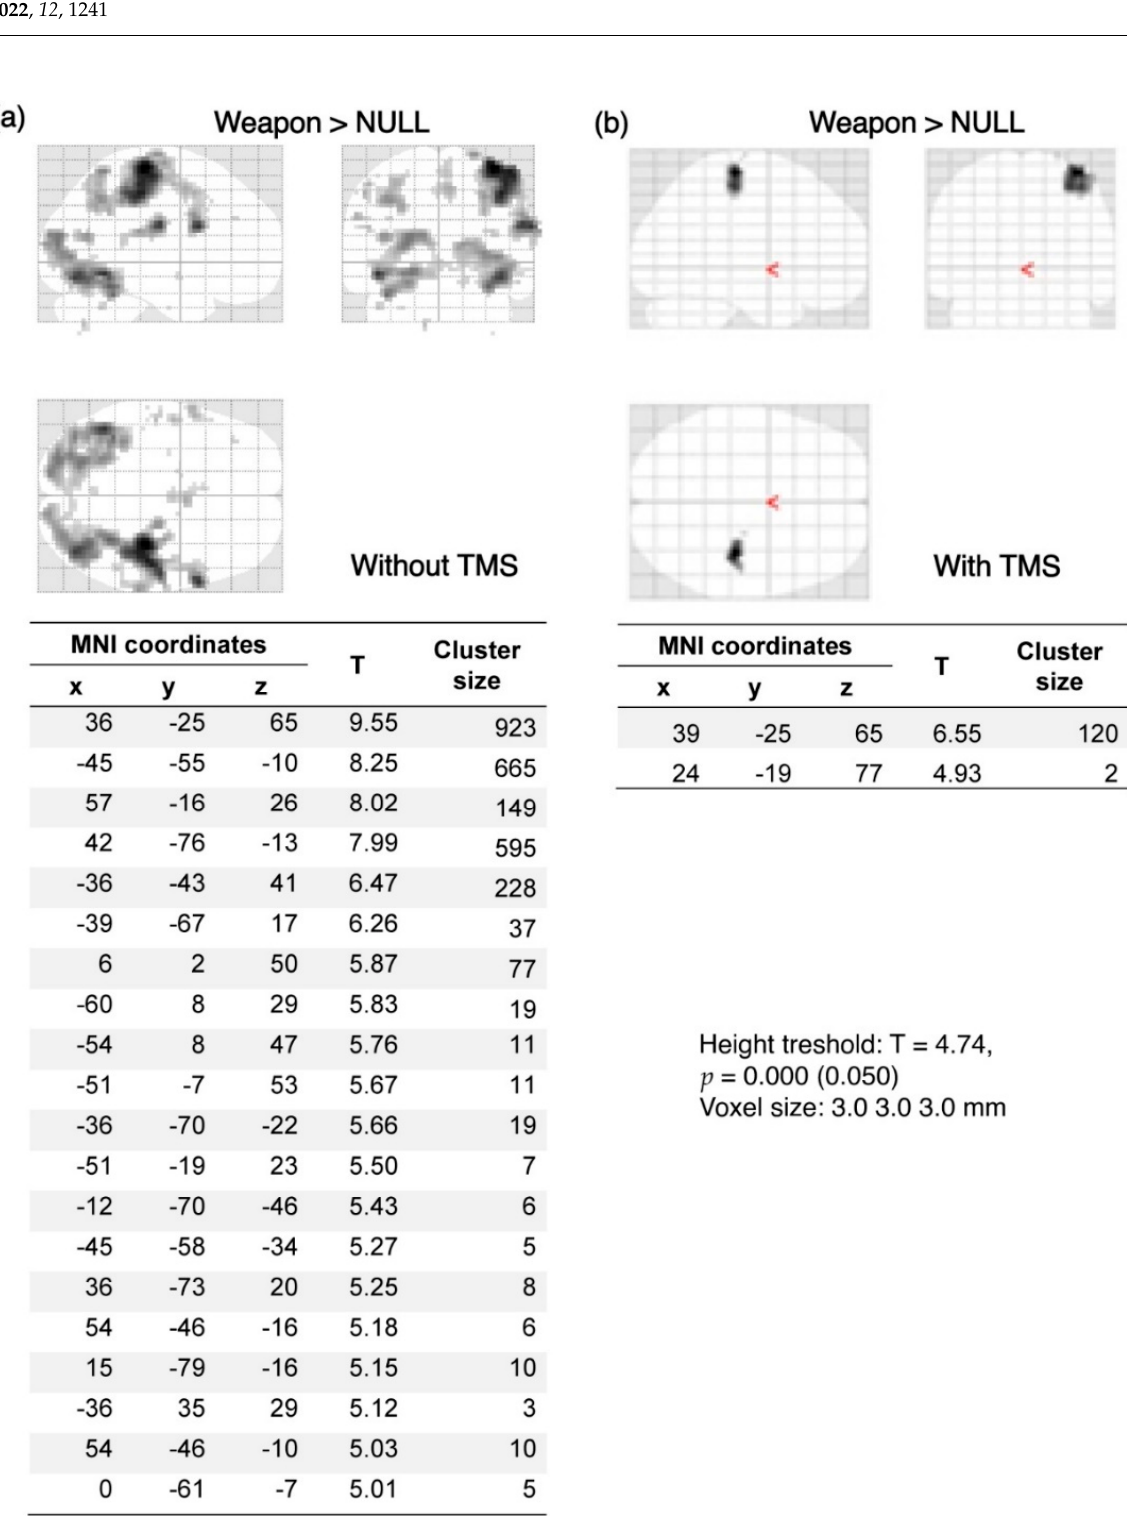
Figure 4. Decrease of BOLD signal activation in response to the visual stimulus of significant significance without ( a ) and after ( b ) using TMS. Tables show 3 local maxima more than 8.0 mm apart. Visibly clear decrease of the BOLD signal in the occipital region after applying TMS. “Weapon” denotes activations evoked by images related to the military compared to brain activation when no stimuli were presented